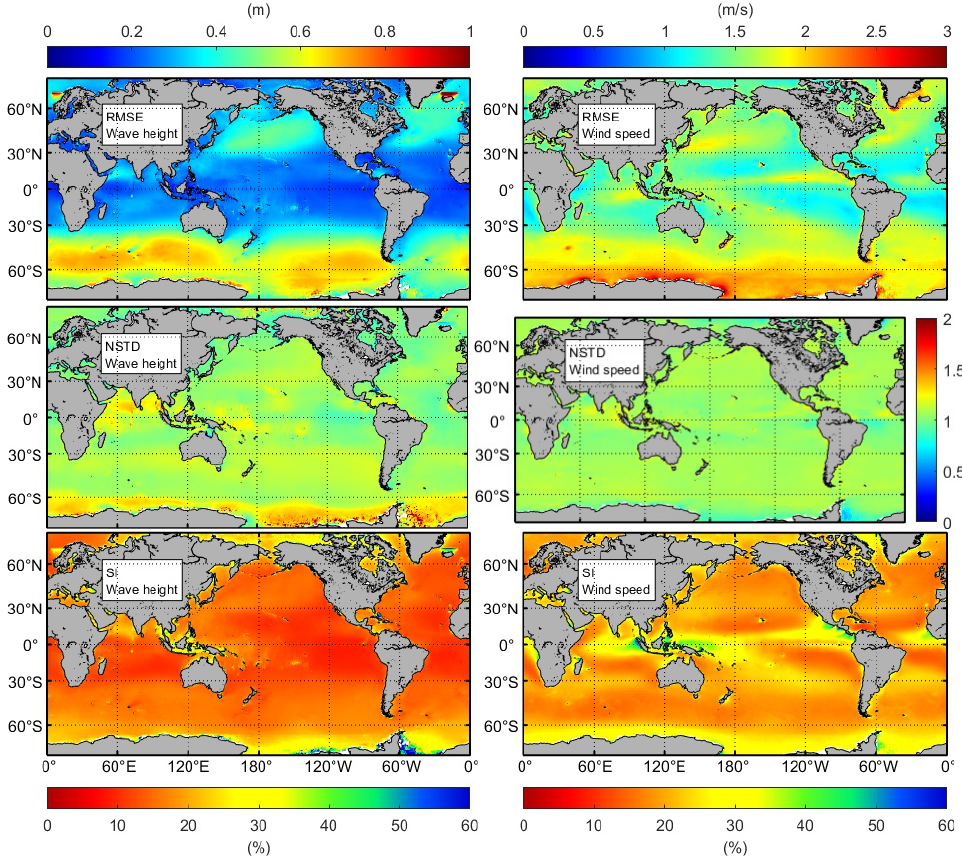
Figure 11. Mean annual variability of RMSE, NSTD, SI (from top to bottom ) between the two reanalyses ( left : significant wave height, right : wind speed).